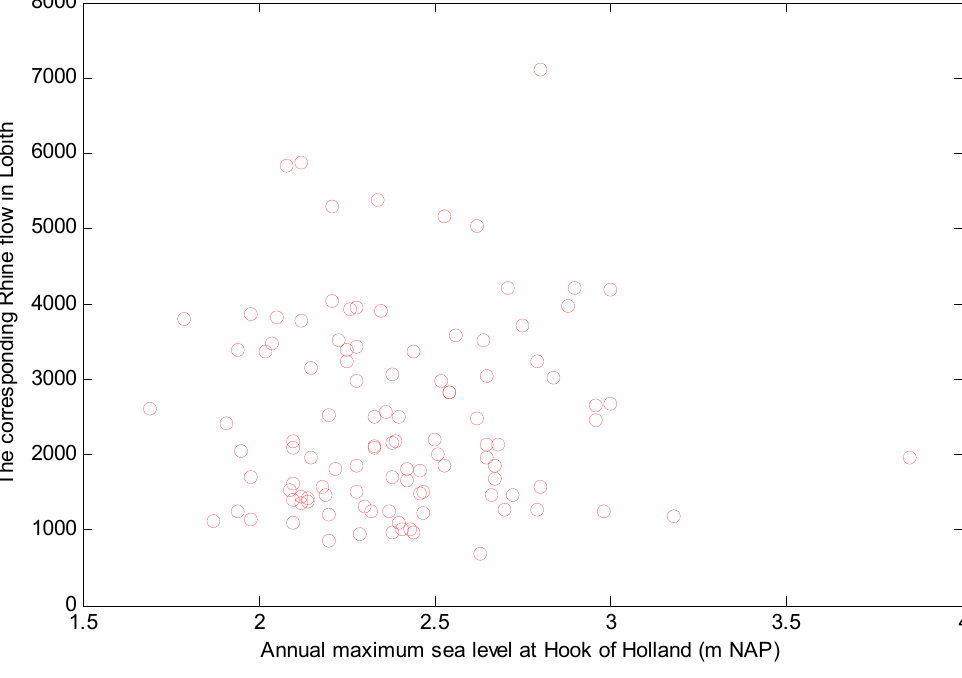
Figure 12. Integration for the exceedance probability of a particular H